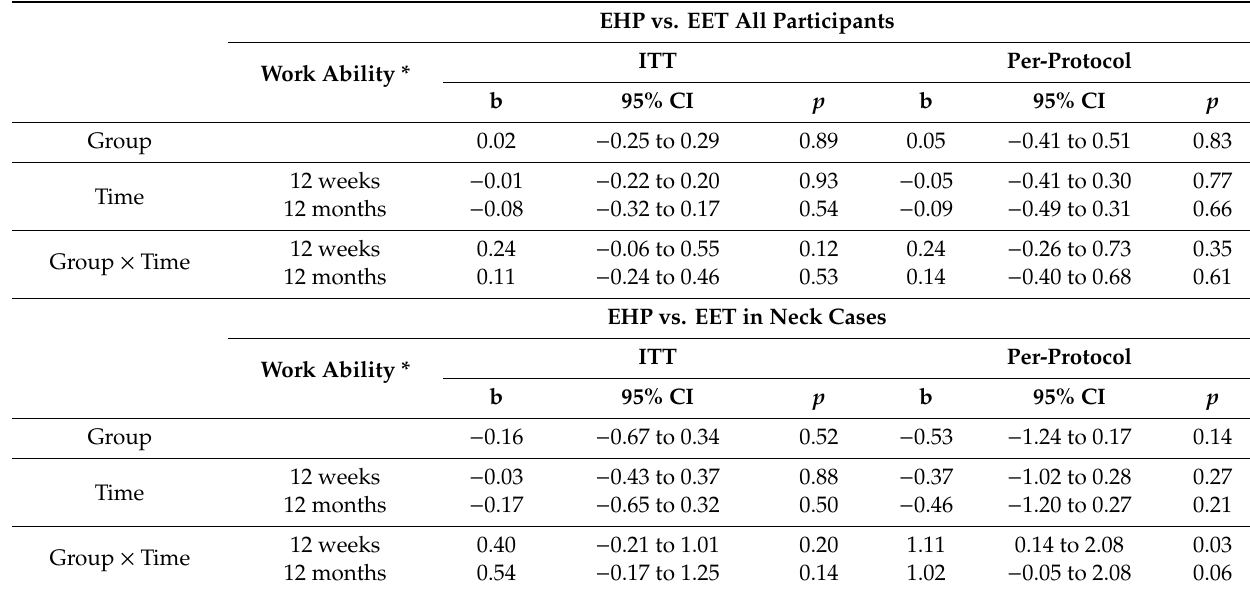
Table 2. Di ff erences in mean work ability scores between groups over time for ITT and Per-protocol analyses a . EHP vs. EET All